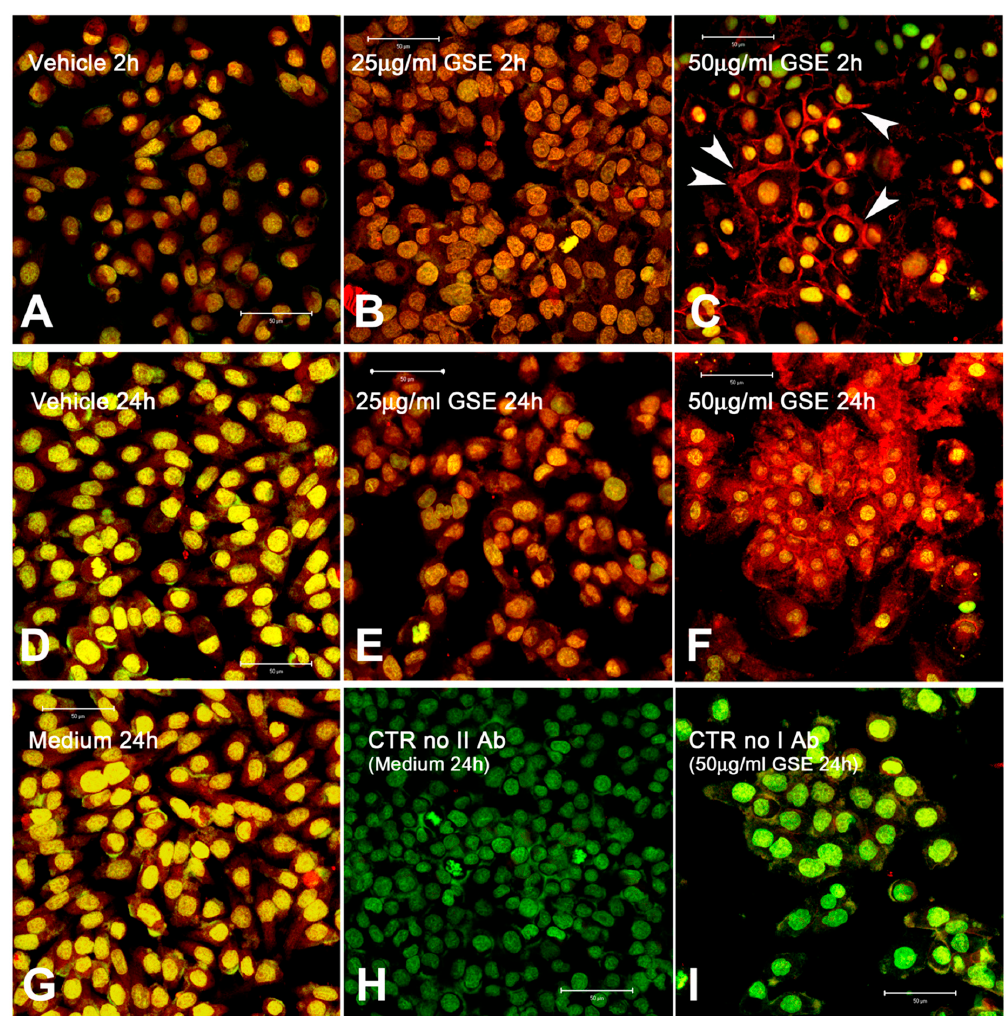
Figure 7. Localization of Cx43 proteins in MCF-7 cells by indirect immunofluorescence using anti-Cx43 antibody conjugated to Alexa Fluor ® 633 (red) and counterstained with SYBR green nuclear dye (green). MCF-7 cells were treated with 0.025% v:v acetonitrile for 2 h ( A ), and for 24 h ( D ), with 25 µ g / mL GSE for 2 h ( B ) and for 24 h ( E ), and with 50 µ g / mL GSE for 2 h ( C ) and for 24 h ( F ). Untreated MCF-7 cells were always included, here ( G ) a representative image related to 24 h. Technical controls without the secondary antibody ( H ) or without the primary antibody ( I ) were also included. In the controls (medium and vehicle), Cx43 is recognized in the cytoplasm (red). Treatment with 25 µ g / mL GSE induces a weak increase in Cx43 immunolabelling at both 2 h and 24 h. A dramatic change in Cx43 localization and plaque formation is induced after 2 h of treatment with 50 µ g / mL, and accumulation of immunolabelled Cx43 is visible after 24 h of treatment. Laser scanning confocal microscope images are results of merged channels (red and green) and were seen under 40 × Neo-Plan objective lens, pinhole = 0.90 μ m. Control cells treated with vehicle ( A , D ), or medium only ( G ). Arrows indicate plaque formation. Images are representative of three independent experiments. Bars = 50 μ m.